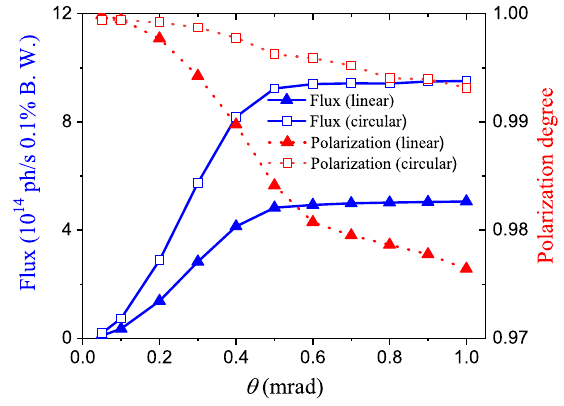
FIG. 6. The photon flux (solid blue) and polarization degree (dotted red) depend on pinhole radius at 7 eV for the linear mode (triangle symbol) and circular mode (square symbol) in the Fig. 8